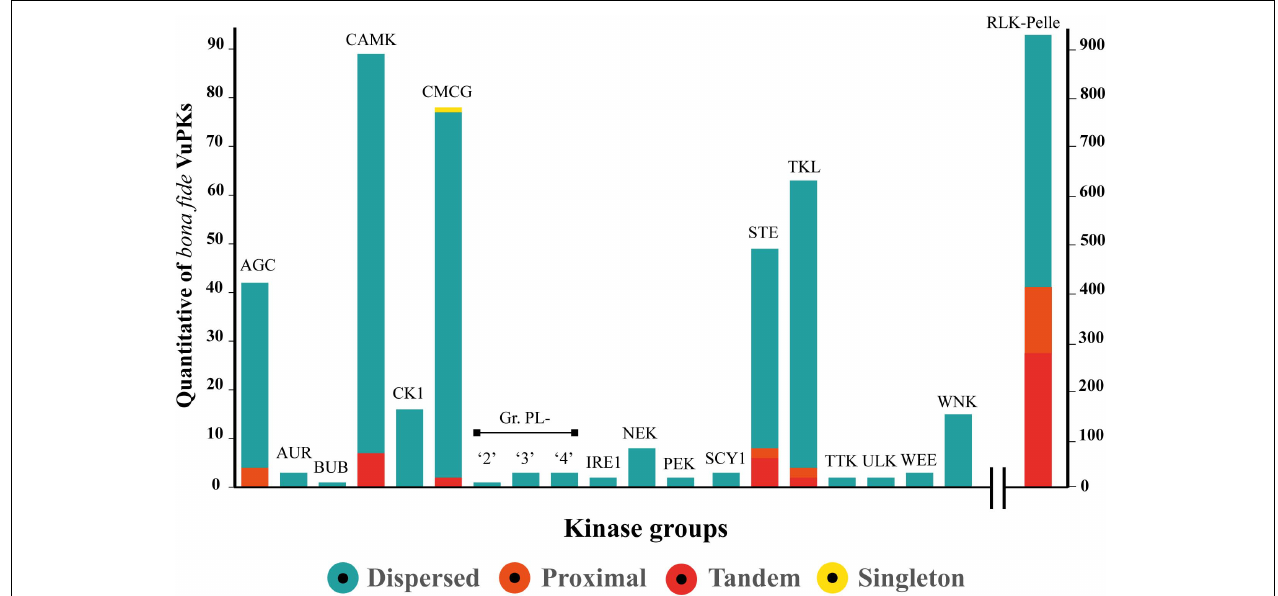
FIGURE 2 | Categories and quantification (represented by the range covered by each color on the axis “ y ” scale) of the main expansion mechanisms of the 20 bona fide VuPK groups searched in the cowpea